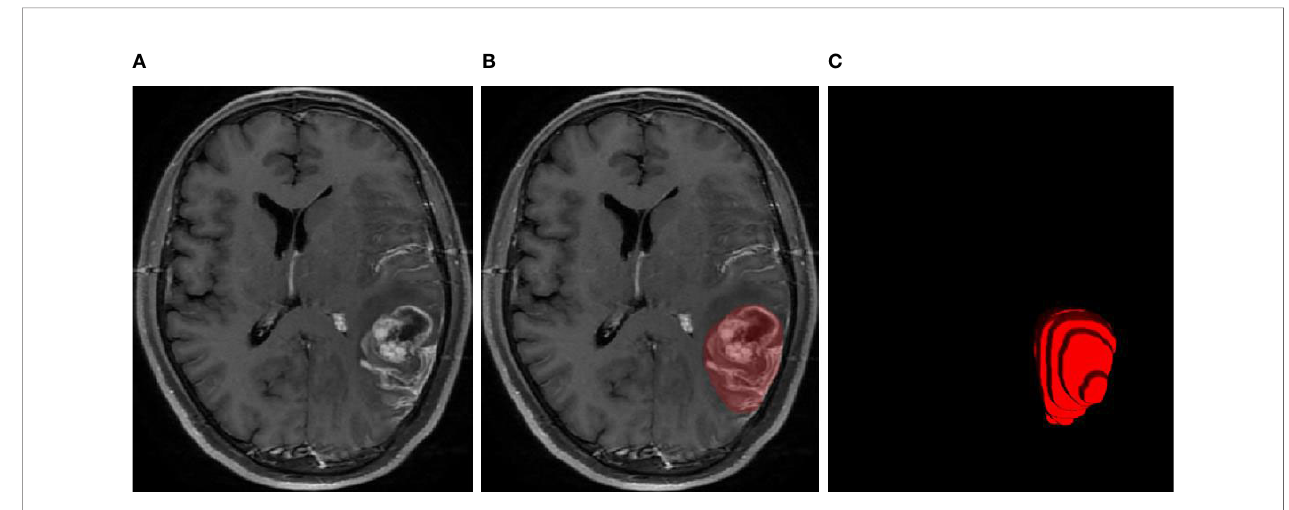
FIGURE 1 | MRI examination of the glioblastoma (A) , GTV contours delineated by human experts (B) , and 3D diagram corresponding to the GTV contours (C)